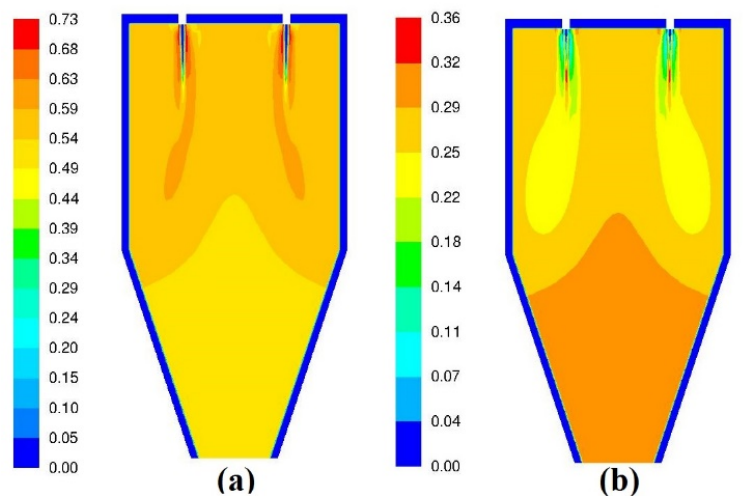
Figure 21. Species distribution in the plane passing through the centers of two opposite burners: ( a ) H 2 and ( b ) H 2 O.